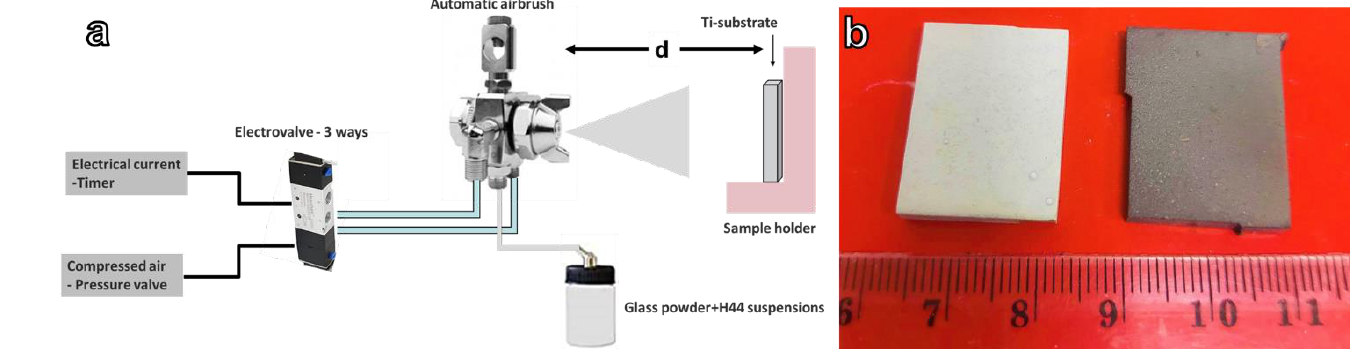
Figure 1. ( a ) Scheme of coating apparatus; ( b ) examples of coated Ti blocks after heat-treatment at 900 °C; on the right : sample heated-treated in the air, on the left : sample heated-treated in argon.